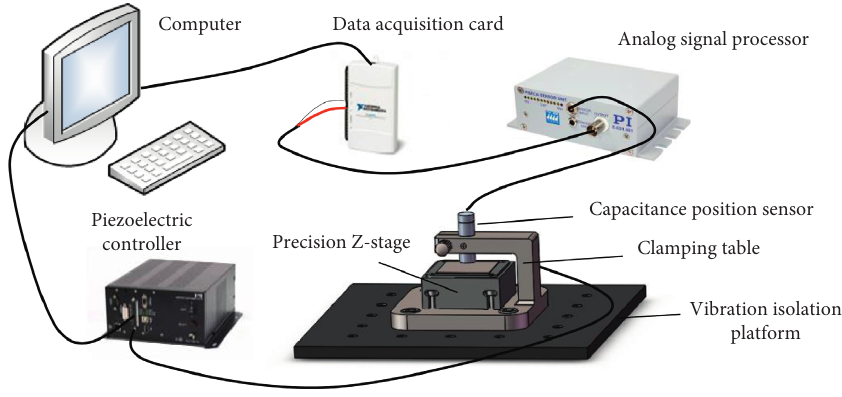
Figure 5: The control system of piezoelectric microposition